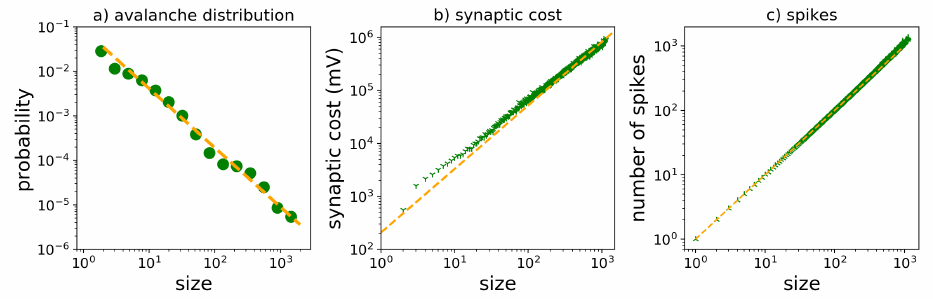
Figure 6. Critical dynamics in a N = 5000 system. ( a ) Avalanche distribution using η = 0.5, w = 4.0 mV, τ = 1.3 ms. The dash line represents a power-law function with α = − 1.56. ( b ) Synaptic cost vs. size. The synaptic cost follows the power-law relation ( β = 1.2 dash line) previously seen in N = 1000 systems. ( c ) Number of spikes vs. size. The spikes also follow the linear relation (dash